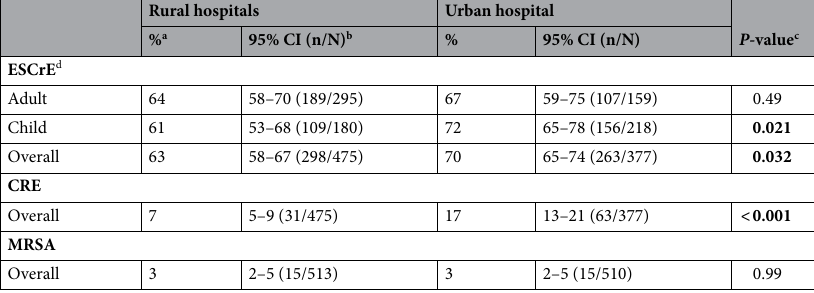
Table 2. Prevalence of colonization with antimicrobial-resistant bacteria in rural and urban hospitals, Kenya. Prevalence estimates, confidence intervals and statistical tests assumed a simple random design. a Prevalence is calculated on a per person level. b CI = confidence interval (n is the number of individuals colonized with ESCrE, CRE or MRSA bacteria, and N is the total number of people sampled). c P -value for